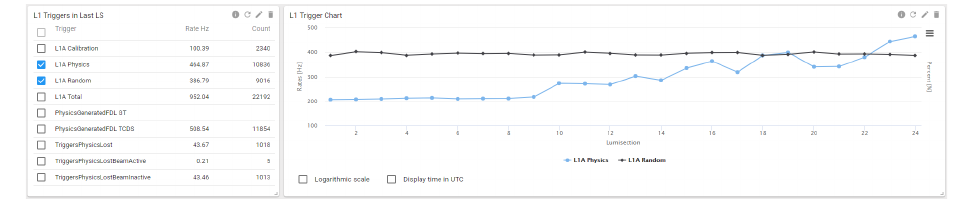
Table 2. List of main OMS controllers (13 in total as of paper publication time)